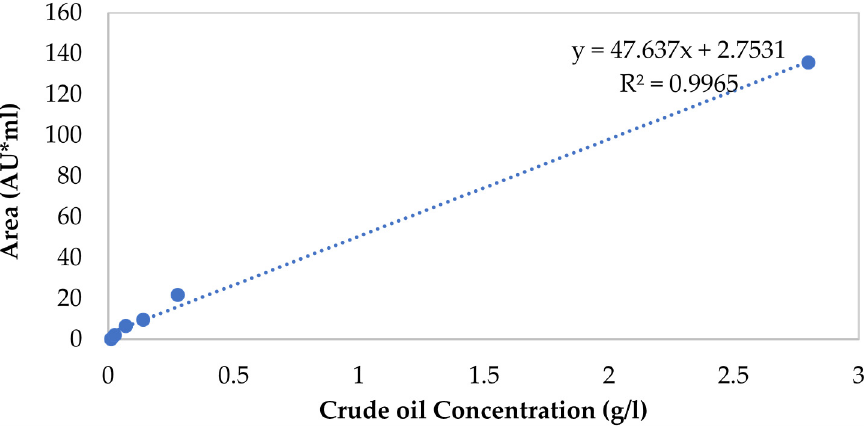
Figure A1. Calibration curve of dissolved crude oil in saline water.